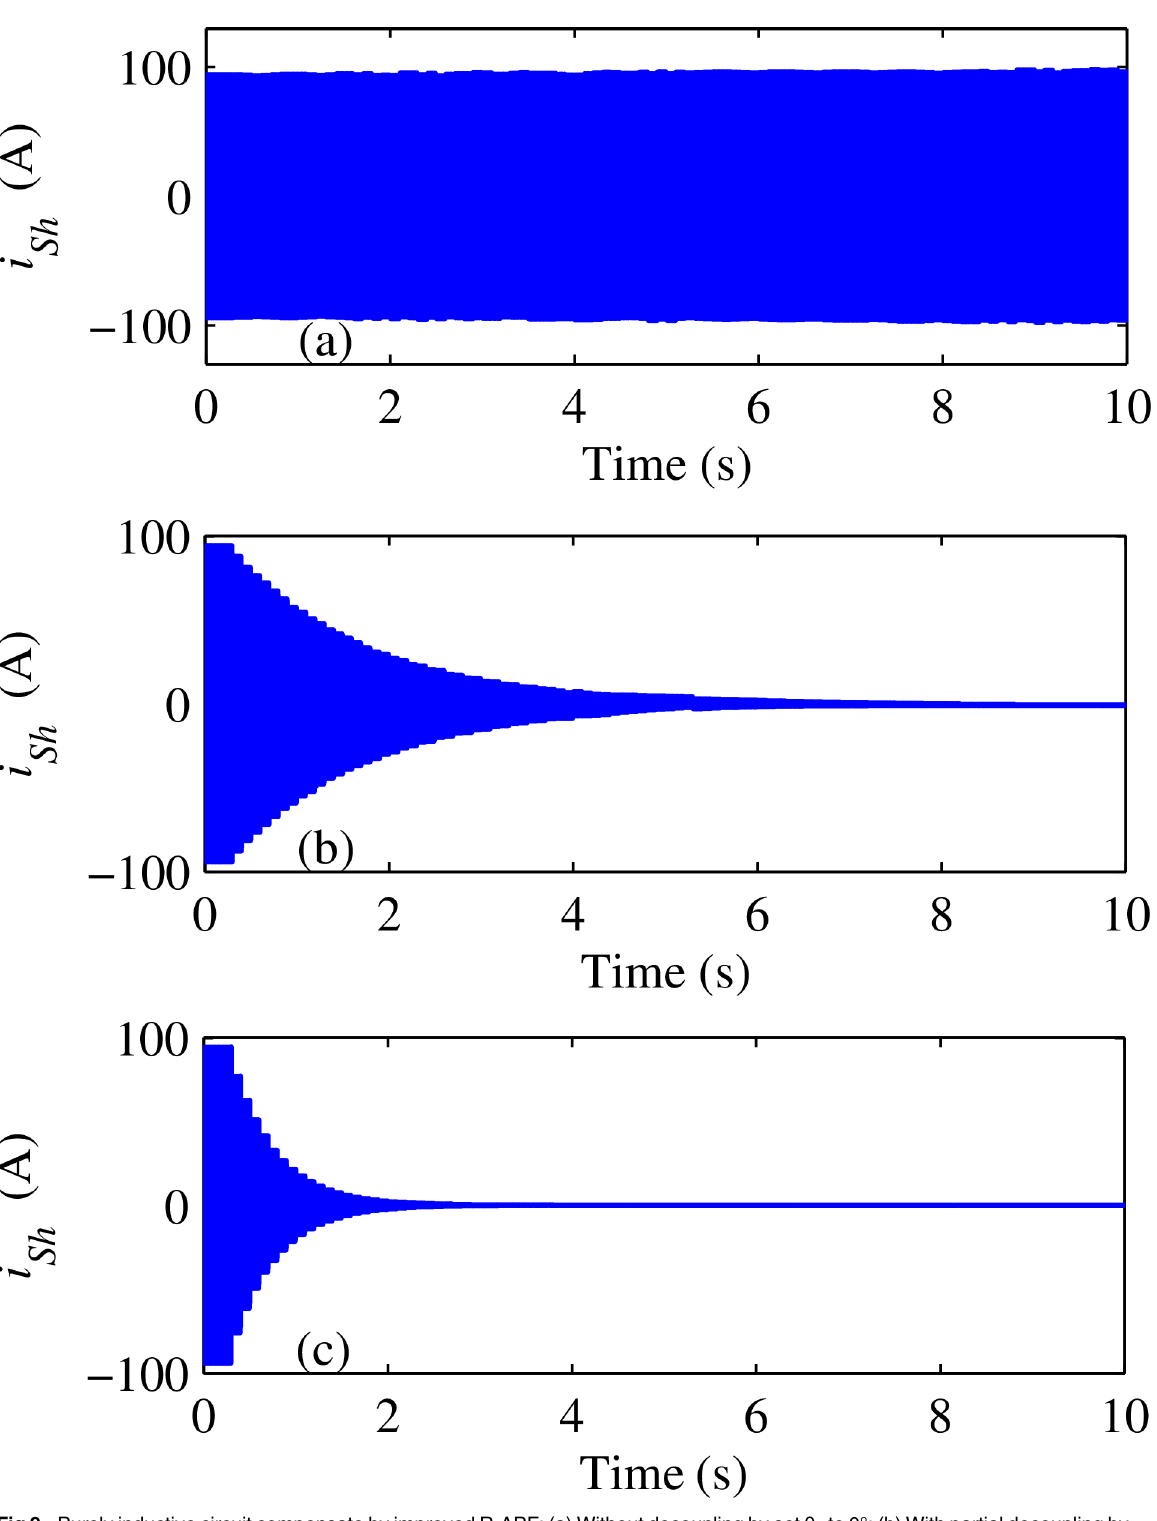
Fig 9. Purely inductive circuit compensate by improved R-APF: (a) Without decoupling by set θ 1 to 0°; (b) With partial decoupling by set θ 1 to 45°; (c) With completely decoupling by set θ 1 to